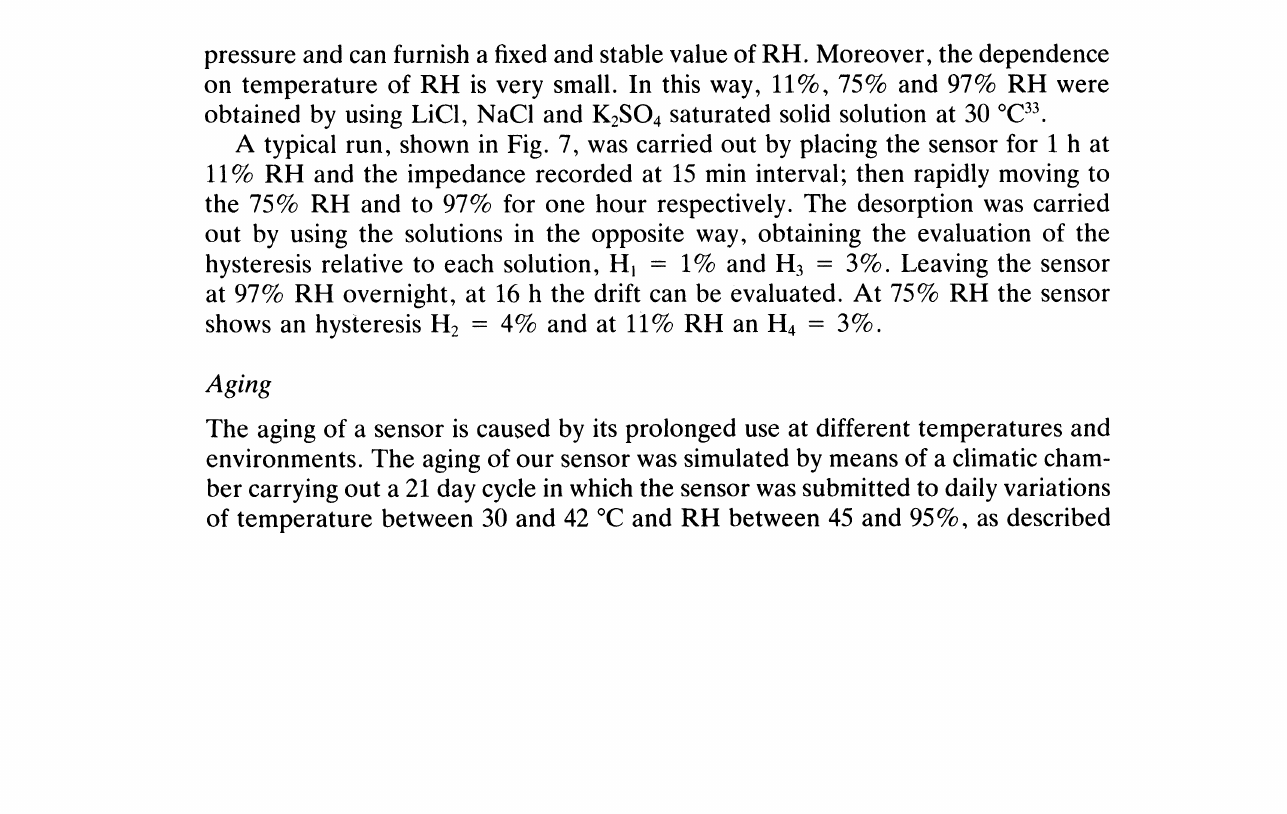
Response time of 950 C sintered compact under adsorption and desorption FIGURE 6